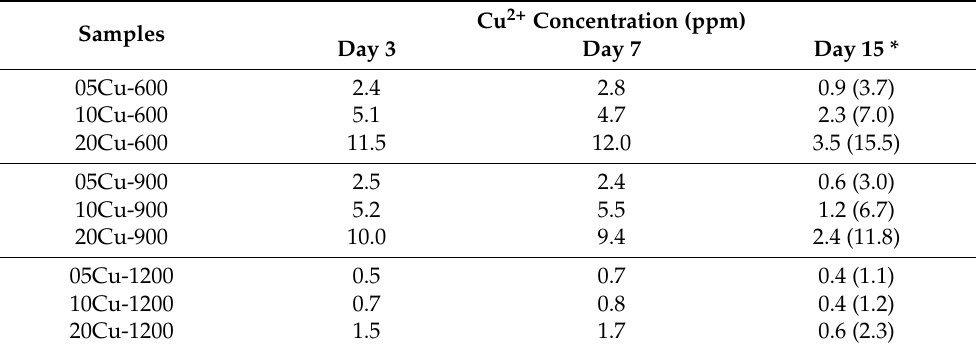
Table 2. Average values (from the nine replicates) of Cu 2+ release (ppm) in standard marrow